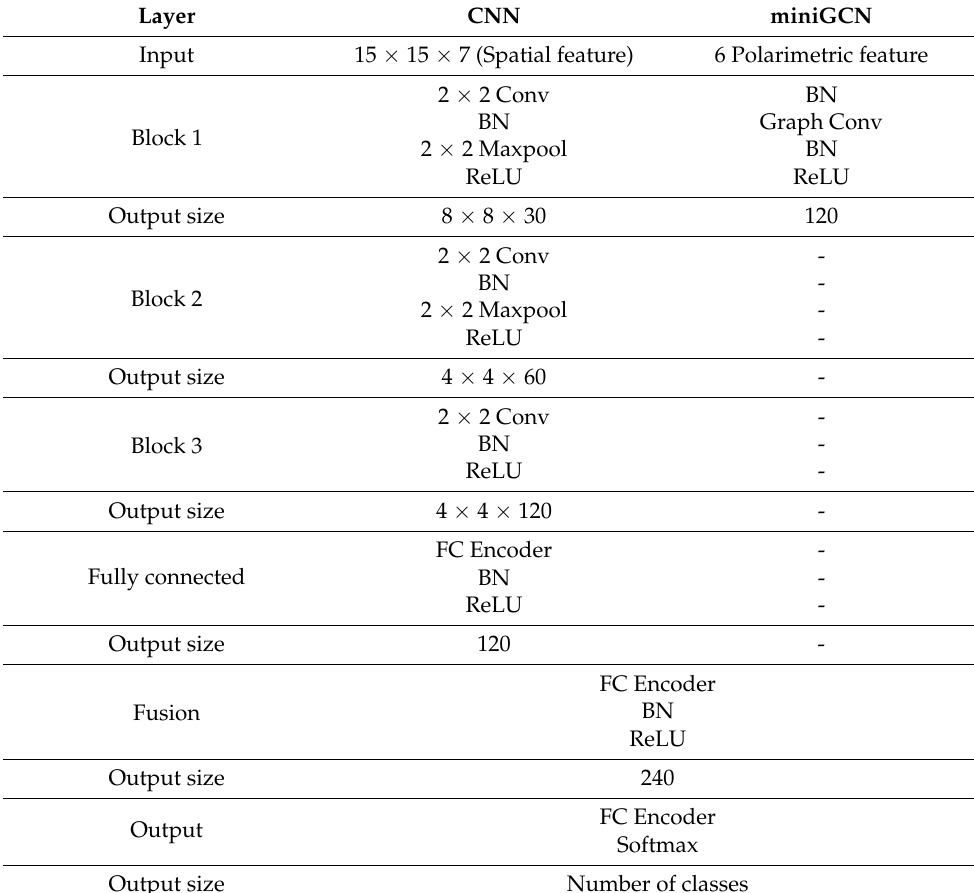
Table 3. The architecture of the dual-branch